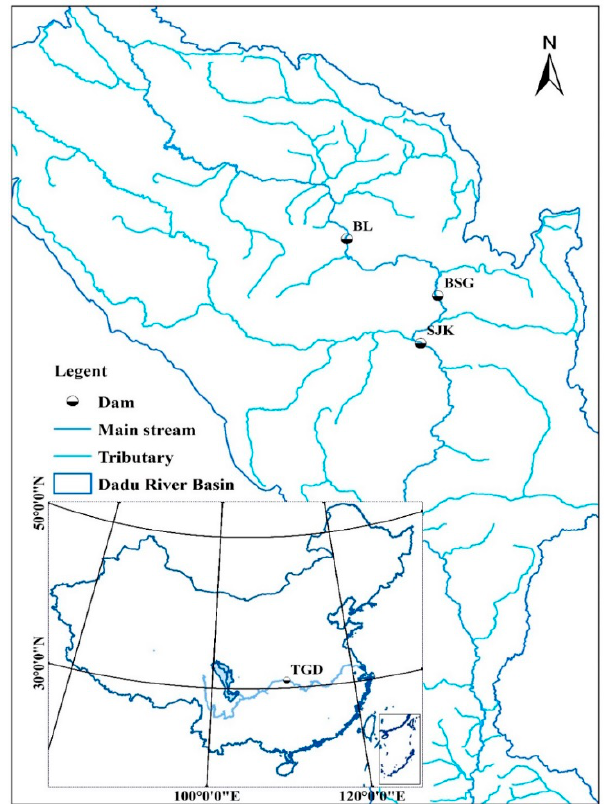
Figure 1. Location of Dadu River Basin and Bala–Busigou–Shuangjiangkou (BL–BSG–SJK) cascade dam system.